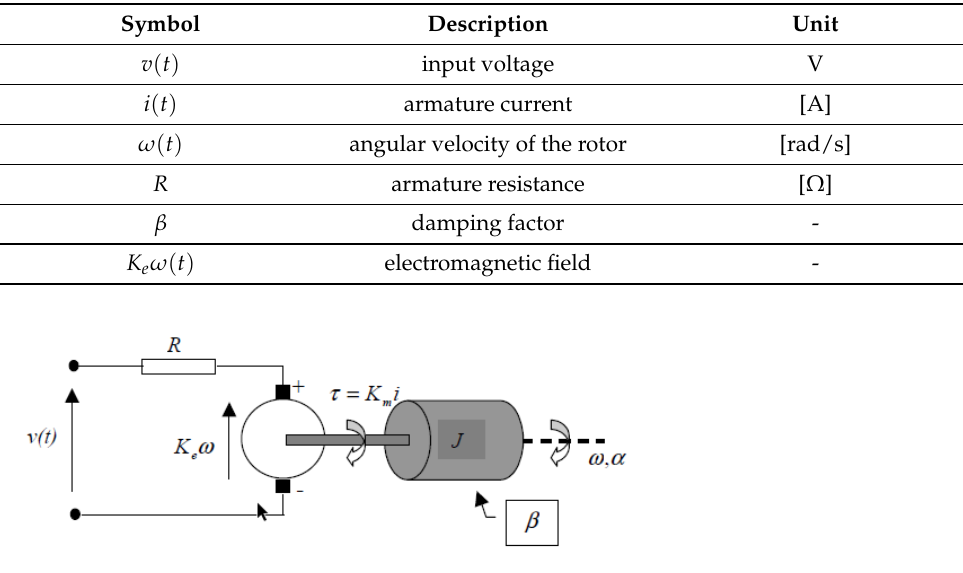
Figure 8. Diagram of DC motor